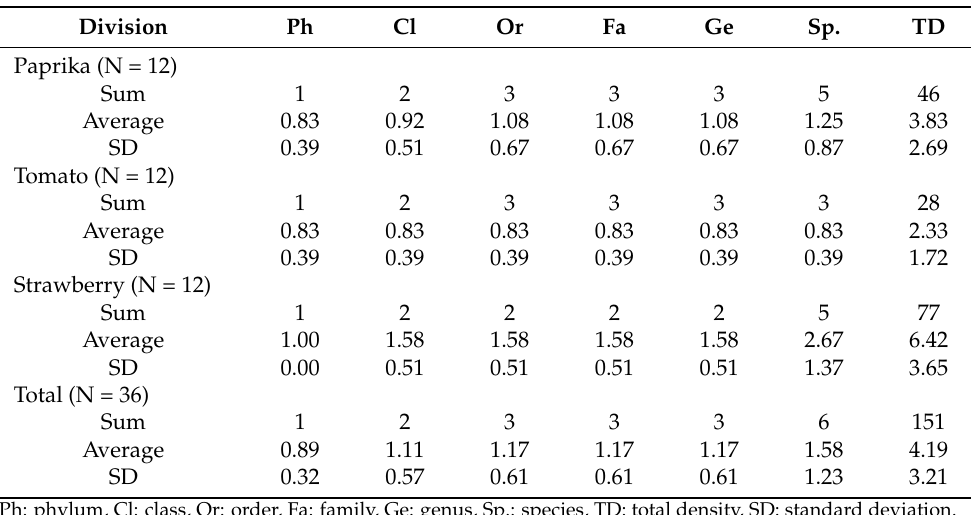
Table 4. Bacteria detected according to the type of crop.